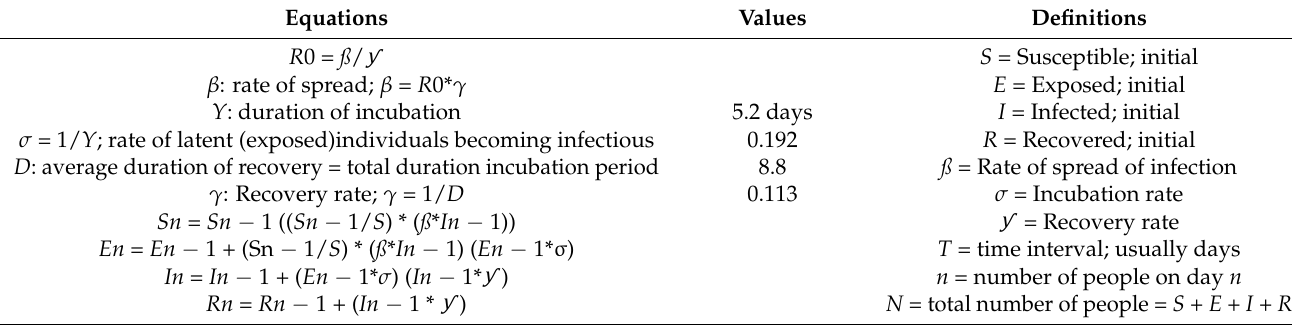
Table 3. Equations and values for SEIR Model. Raw data for the SEIR Model was retrieved from the Singapore Ministry of Health COVID-19: Cases in Singapore. Last updated 2 May 2020.